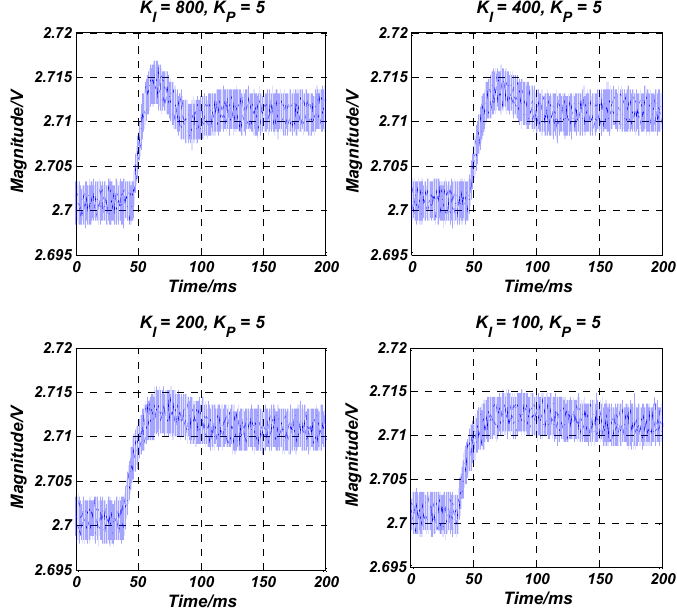
Figure 12. Measured step-up waveforms of the LPF’s output with different the integral . term K I